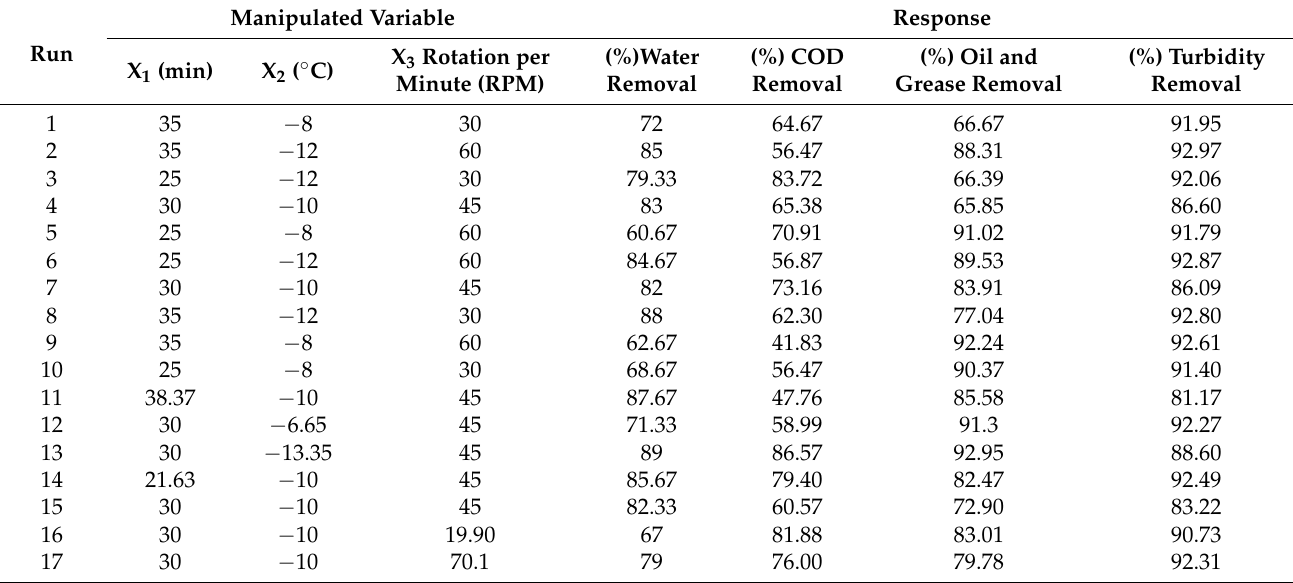
Table 2. Design of experiment and